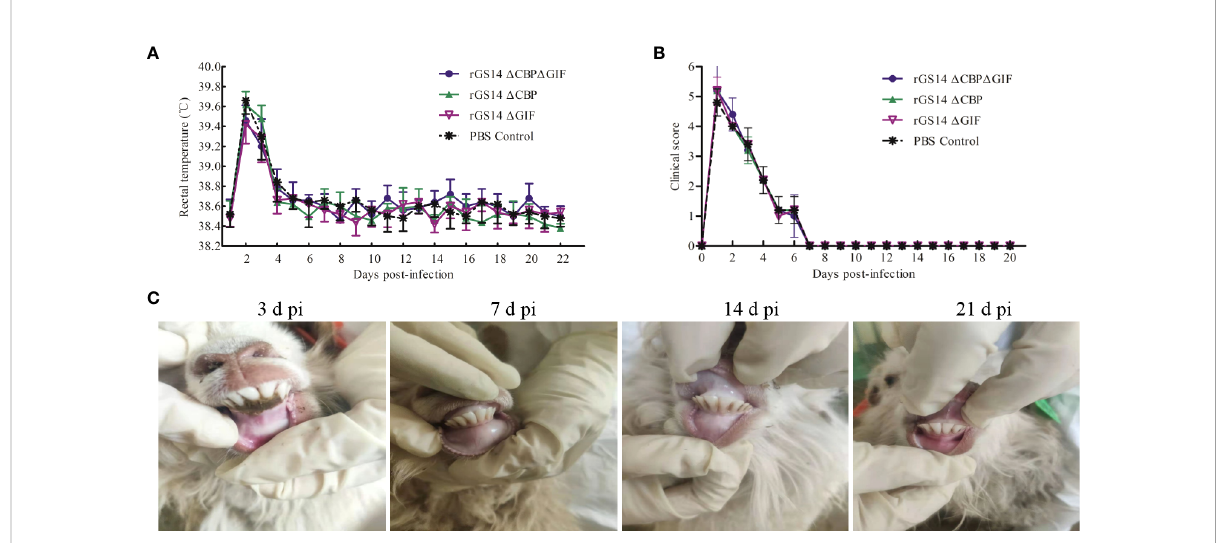
FIGURE 4 Biosafety assessment of rGS14- D CBP, rGS14- D GIF and rGS14- D CBP- D GIF. (A) The rectal temperature of lambs inoculated with rGS14- D CBP, rGS14- D GIF, rGS14- D CBP- D GIF or PBS from the 1st to 21 st day post-inoculation. The bars represent the standard error of the mean. (B) Mean clinical score in lambs inoculated with rGS14- D CBP, rGS14- D GIF, rGS14- D CBP- D GIF or PBS from the 1st to 21 st day post-inoculation. The bars represent the standard error of the mean. (C) The cut healed on 5 to 7 days post inoculation and no pathological changes was observed in all the animals during 21 days post-inoculation. d pi = days